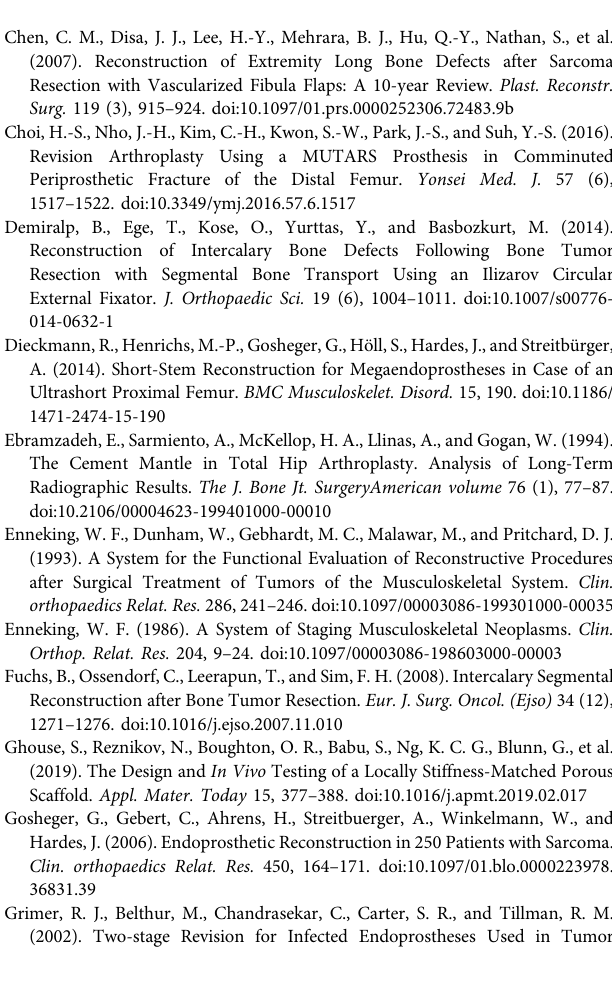
Supplementary Figure S1 | Schematic diagram of the curved stem. (A) The positional relationship of the curved stem and bone. (B) The porosity of the curved stem. Supplementary Figure S2 | Schematic diagram of different cross section of the curved stem. (A) The base of the curved stem. (B) The middle part of the curved stem. (C) The end of the curved stem. (D) The tip of the curved